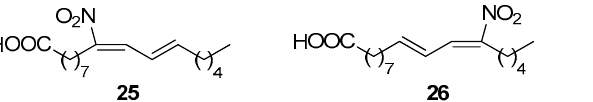
Figure 8. Structures of the NO 2 -FAs reported by Denicola and coworkers, which act as activators of SIRT6 [97].